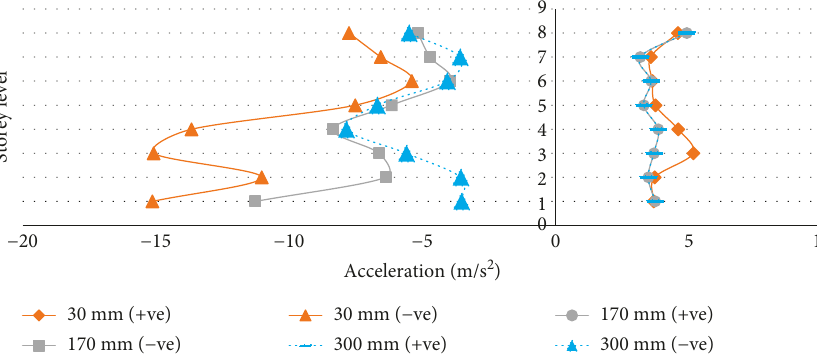
Figure 20: Acceleration response of BI buildings considering different seismic gaps.